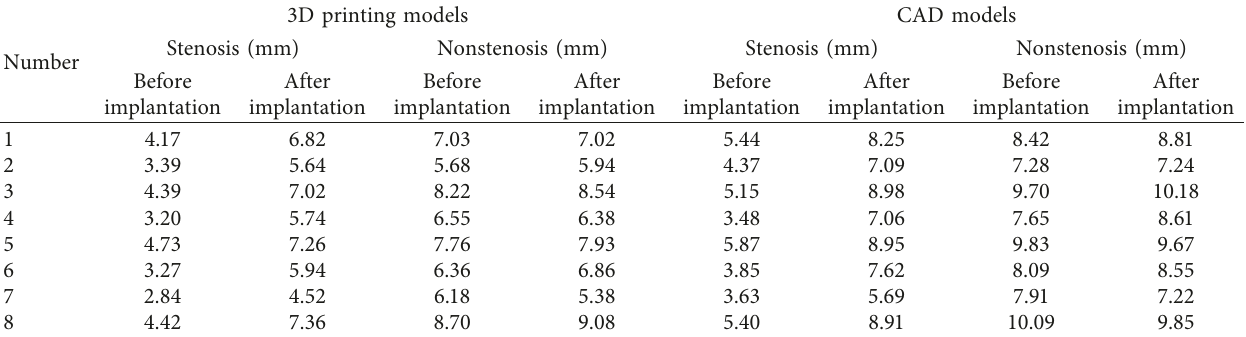
Table 1: 3D printing physical models vs CAD models of 3D measurements of blood vessels in stenosis and nonstenosis. 3D printing Number